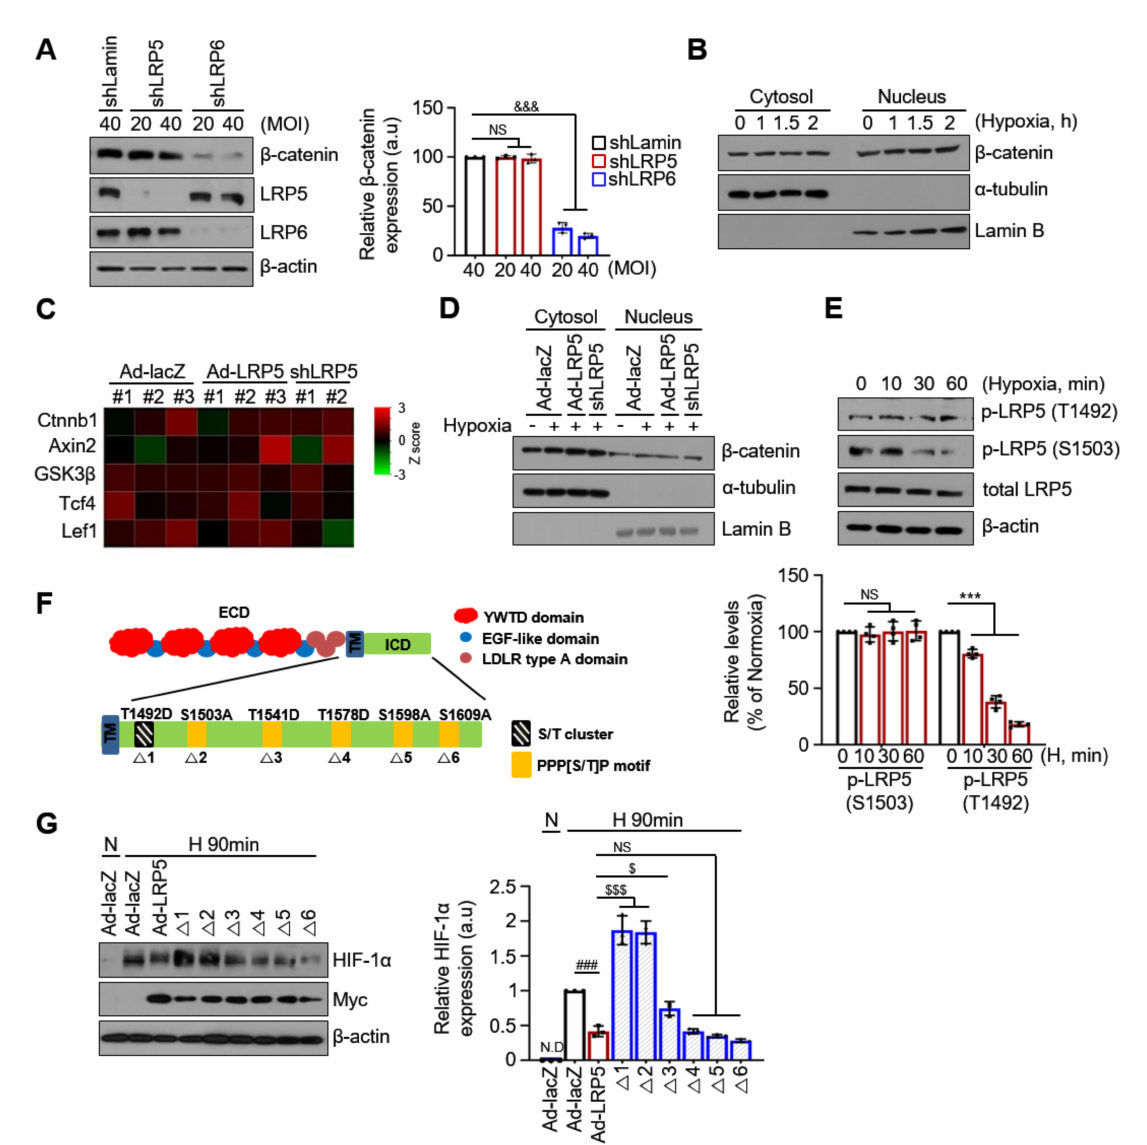
Figure 6. LRP5 regulates HIF-1 α stability independently from the Wnt β -catenin signaling pathway. ( A ) Representative western blot analysis showing the expression of β -catenin in shLRP5 or shLRP6-infected cardiomyocytes. shLRP5/6-1: MOI 20, siLRP5/6-2: MOI 40. n = 3/group. Means ± SD. &&& p < 0.001 shLRP6 versus shLamin; NS, no significance. ( B ) Representative western blots showing β -catenin expression in cytosolic and nuclear-fractionated lysates at the indicated hypoxic times. α -tubulin and lamin B were used as cytoplasmic and nuclear protein controls, respectively. n = 3/group. ( C ) Heatmap of Wnt/ β -catenin signaling-related genes in Ad-lacZ-, Ad-LRP5-, and shLRP5-infected hypoxic cardiomyocytes. Fold change was calculated relative to the normoxic Ad-lacZ control. Ad-lacZ and Ad-LRP5; n = 3, shLRP5; n = 2. ( D ) Representative western blots showing β -catenin expression in cytosolic and nuclear-fractionated lysates after infection with adenoviruses as indicated. α -tubulin and lamin B were used as cytoplasmic and nuclear protein controls, respectively. n = 3/group. ( E ) Cardiomyocytes were exposed to hypoxic conditions at the indicated times. Representative western blots showing the expression levels of p-LRP5 (S1503) and p-LRP5 (T1492). Protein levels were normalized to total LRP5 levels. n = 4/group. Means ± SD. *** p < 0.001 versus Normoxia; NS, no significance. ( F ) Schematic diagram of LRP5 phosphorylation site and site-directed mutagenesis. ( G ) Representative western blots showing the effect of LRP5 mutants on HIF-1 α expression. Protein levels were normalized to β -actin levels. n = 3/group. N.D: non-detected. Means ± SD. ### p < 0.001 Ad-LRP5 versus Ad-lacZ; $ p < 0.05, $$$ p < 0.001 versus Ad-LRP5; NS, no significance. All images shown are representative of those obtained from at least three independent